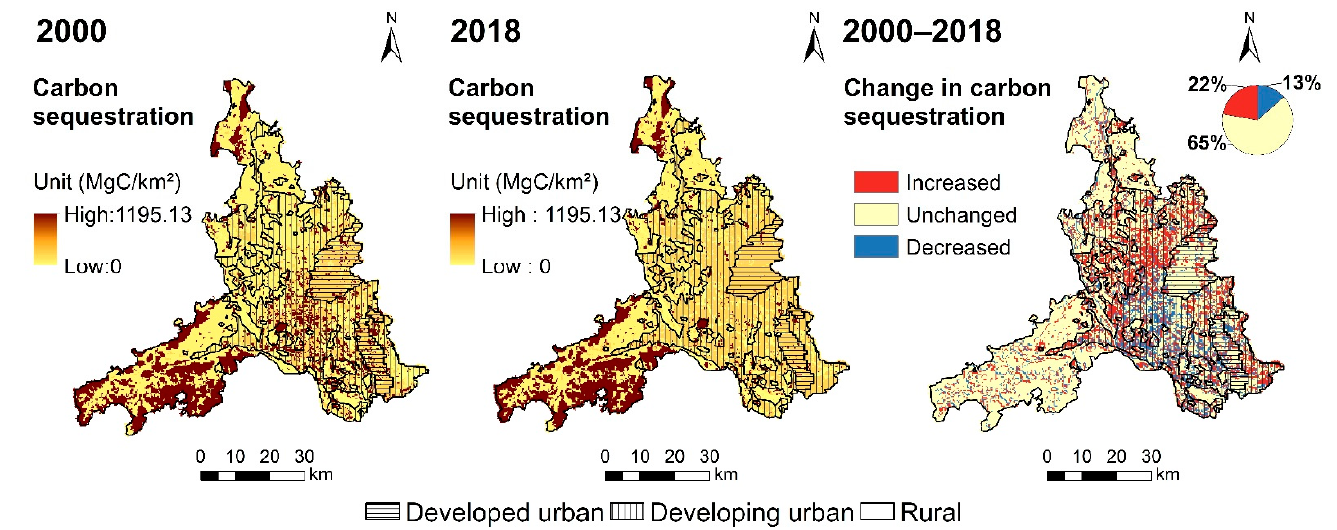
Figure 8. Spatial patterns of carbon sequestration in Foshan from 2000 to 2018.